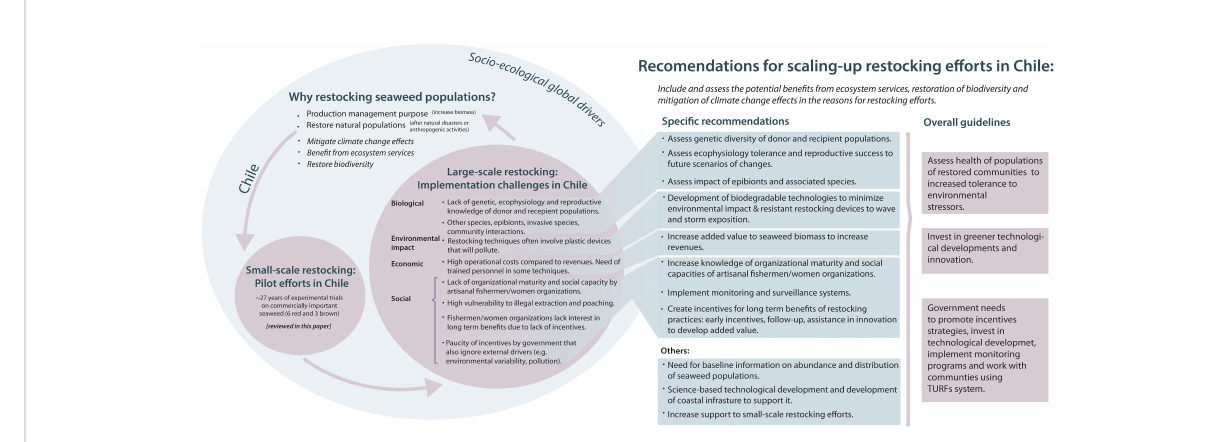
FIGURE 9 Conceptual fi gure summarizing the challenges and recommendations for scaling-up restocking efforts for seaweed populations in